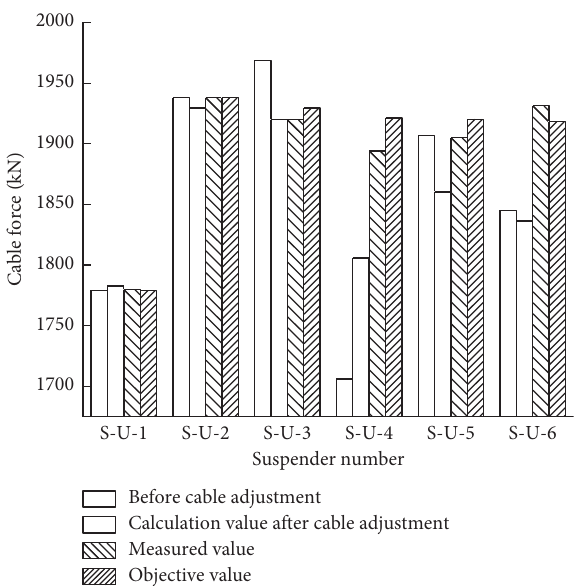
Figure 4: Cable forces before and after adjustment (S-U-1 ∼ S-U-6). Table 2: Adjusted cables and cable forces before and after